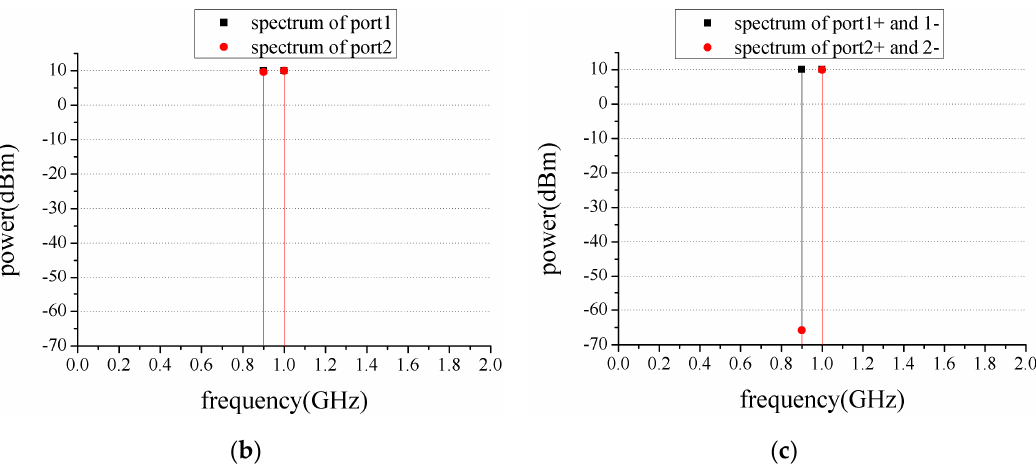
Figure 8. ( a ) The noise module of the STI and the DTI. ( b ) Spectrum of the STI; and ( c ) spectrum of the DTI.